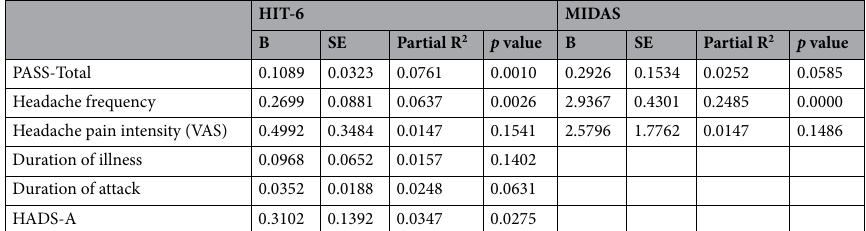
Table 4. Multiple regression analyses for headache-related disability in migraine